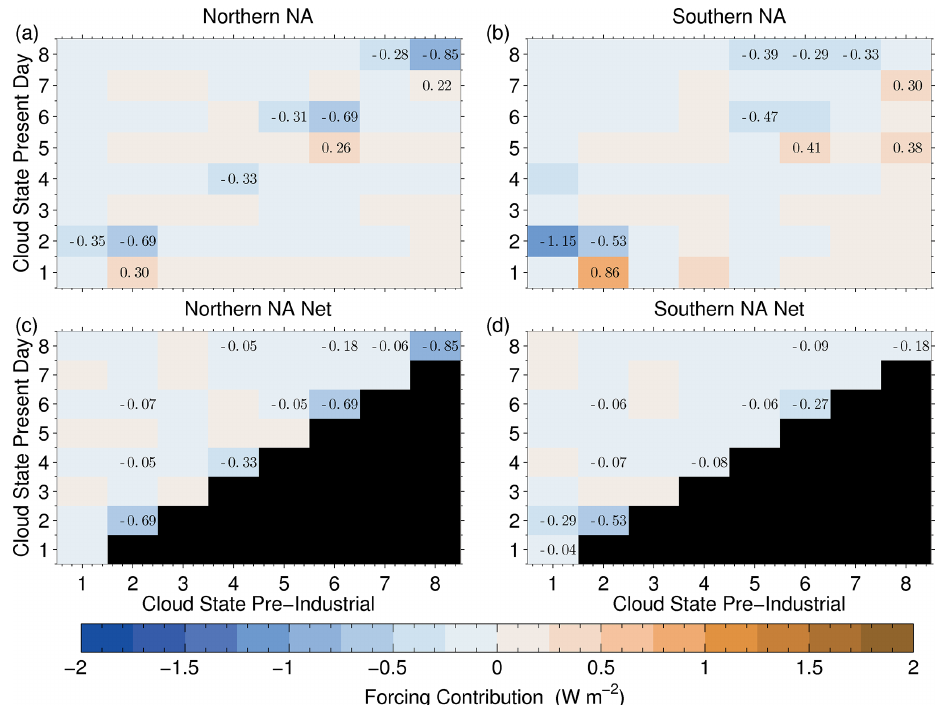
Figure 18. Contributions (colours; the highest 10 values in absolute magnitude are also labelled with text) to the surface ACI forcing for the different combinations of cloud state in the PI emission run ( x axis) and in the PD emission run ( y axis). The cloud states are the eight different possible combinations of low-, mid- and high-altitude clouds (see Fig. 17). The overall contribution is shown, which includes the frequencies of occurrence such that the sum of all of the values gives the overall regional mean contribution. (a) The northern NA region; (b) the southern NA region. The top row shows all of the combinations. In the bottom row plots, the contributions due to PI to PD transitions between states are added to the same transition between PD and PI in order to get the net contribution; see Appendix G for details of